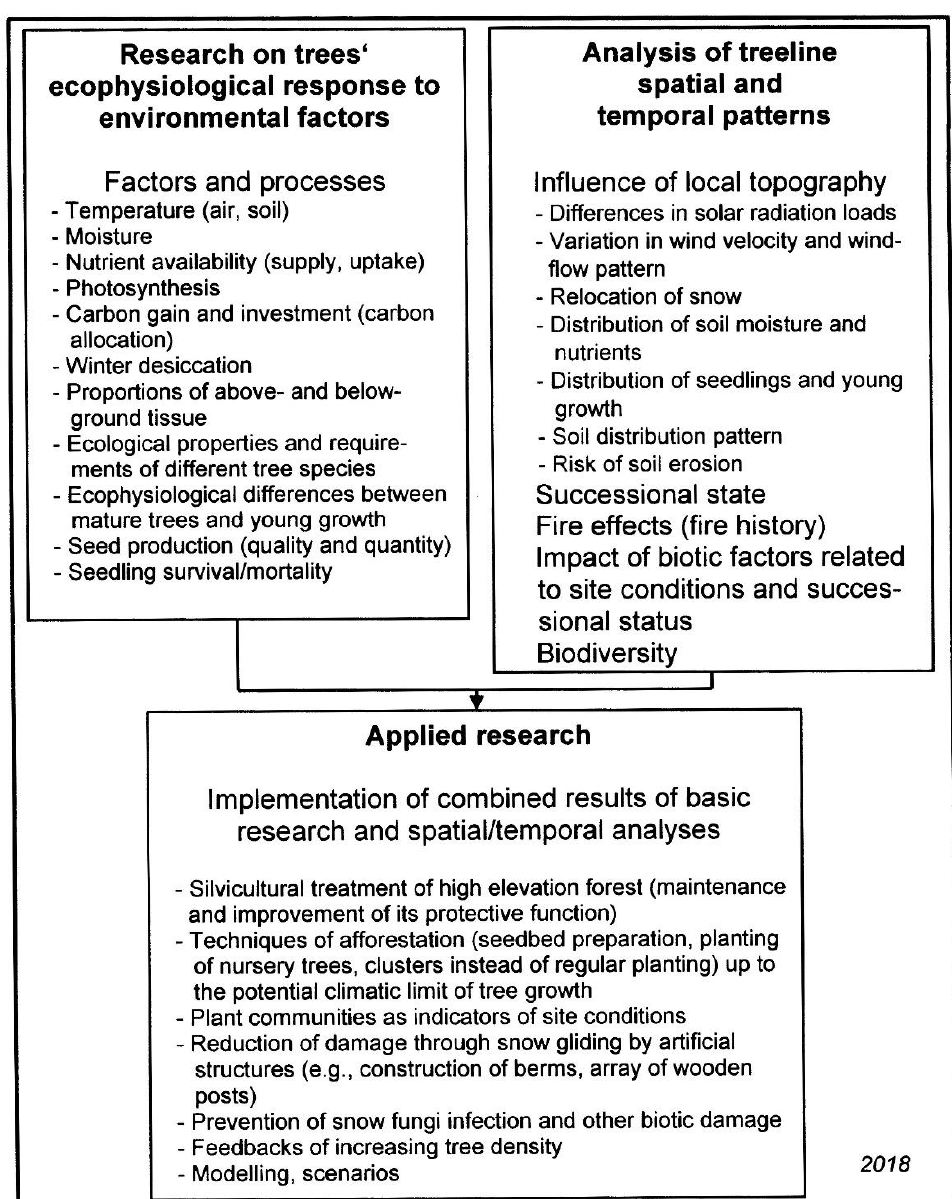
Figure 2. Fundamentals of treeline research and practical implementation.